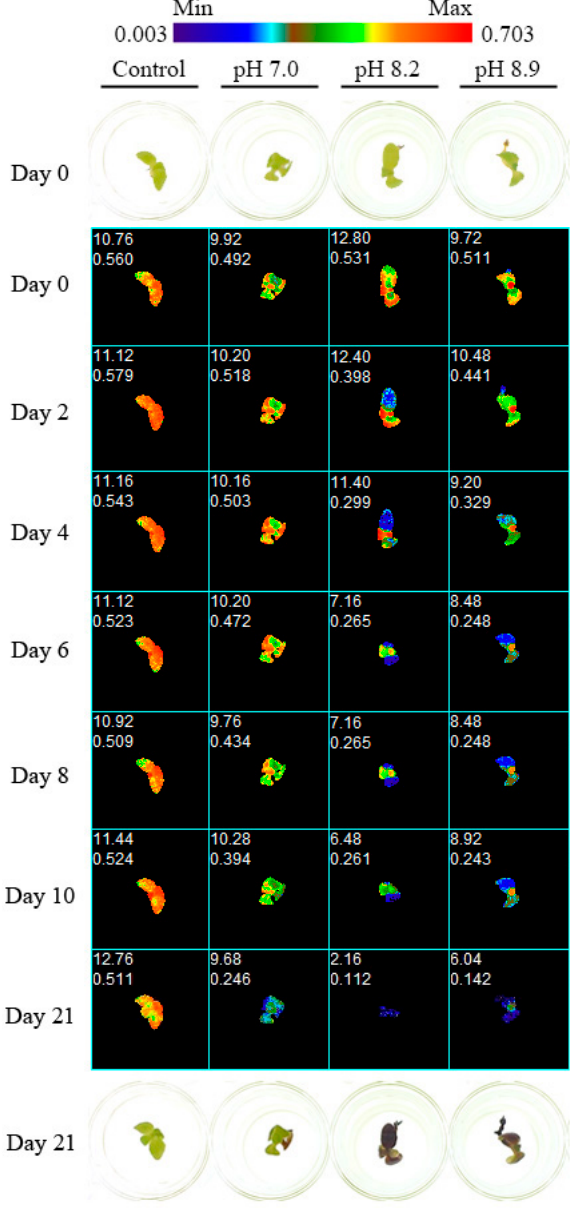
Figure 1. Dynamics of F v /F m over time for four R. fortunei seedlings subjected to increasing pH treatments (control – pH 6.2, pH 7.0, pH 8.2, pH 8.9). For days 0 and 21, RGB images are shown. Values in the upper left corner of the chlorophyll fluorescence images are the projected area in pixels and the mean F v /F m of the seedling in the well.